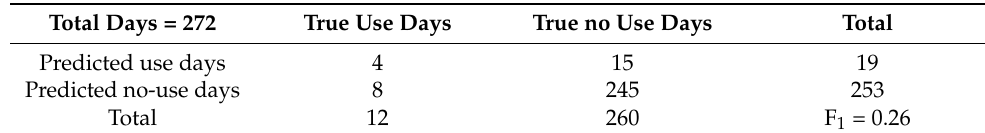
Table 3. Confusion matrix for predicting daily indoor PM 2.5 time series with vs. without rescue medicine use, with F 1 score.